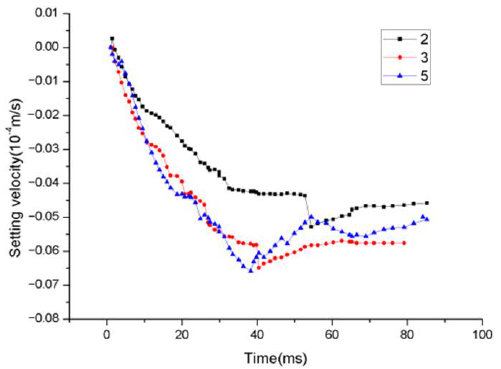
Figure 9. Falling velocity rates for dendrites 2, 3, and 5.